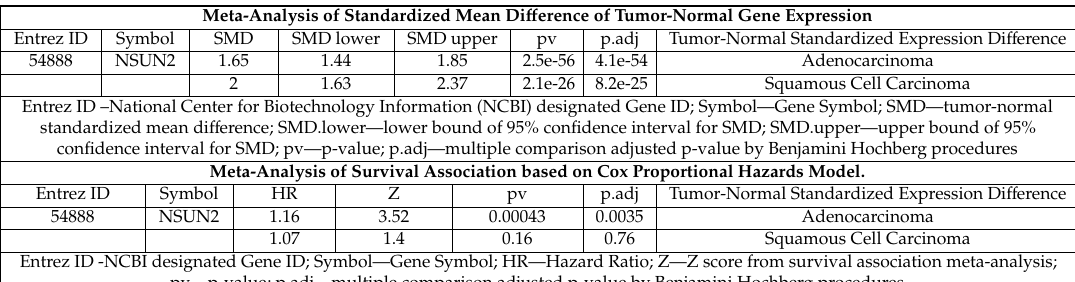
Figure 4. Meta-analysis of NSUN2 for changes in gene expression and survival: All available datasets on Lung Cancer Explorer [114] were assessed by meta-analysis for ( A ) associations between gene expression of tumor vs. normal and ( B ) survival using the default settings in the online server. Table 2. Systematic analysis results for NSUN2 in lung cancer as determined using Lung Cancer Explorer